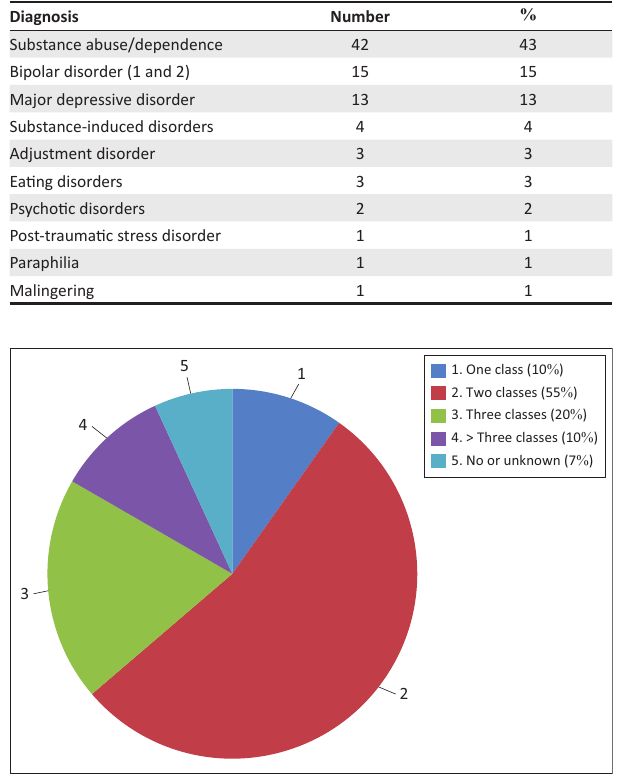
FIGURE 3: Number of classes of medication on discharge of patients with borderline personality disorder at Helen Joseph Hospital during